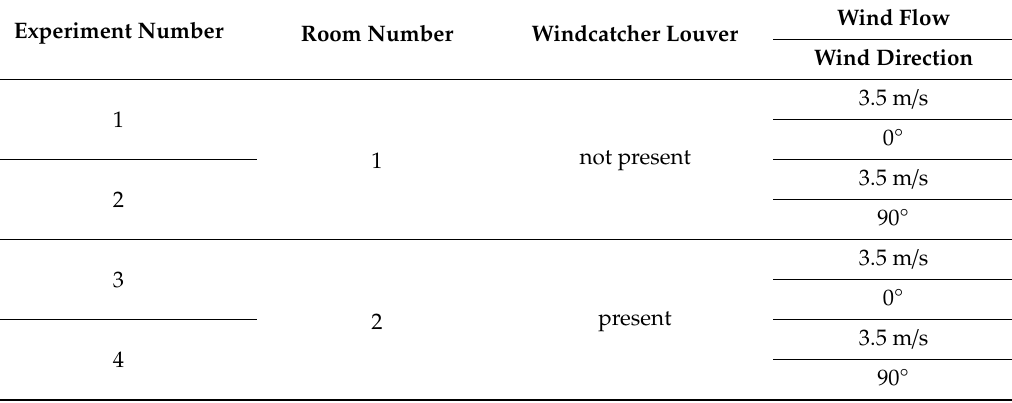
Table 5. Experimental method and location of the